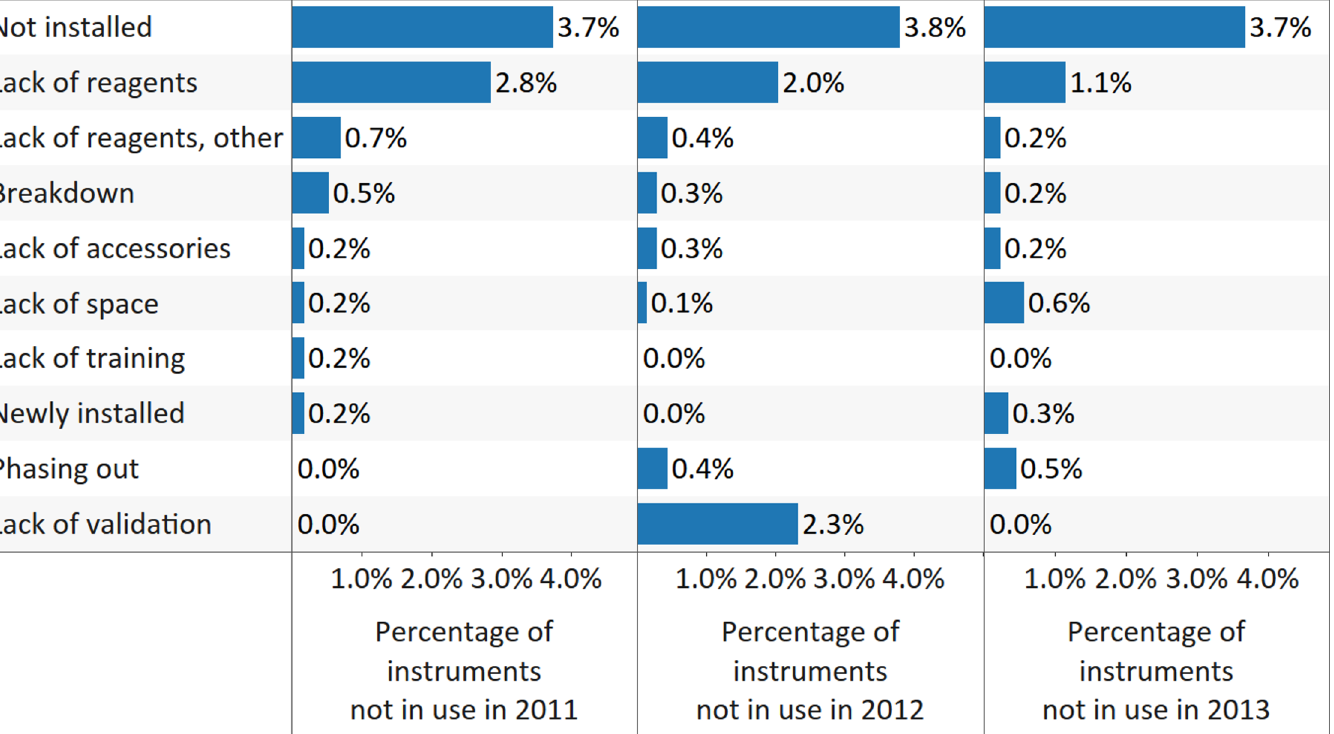
Fig 11. The main reasons for nonutilization of viral load (VL)/early infant diagnosis (EID) instrumentation for all reporting countries. Data labels indicate the percentage from total number of reported instruments in a particular